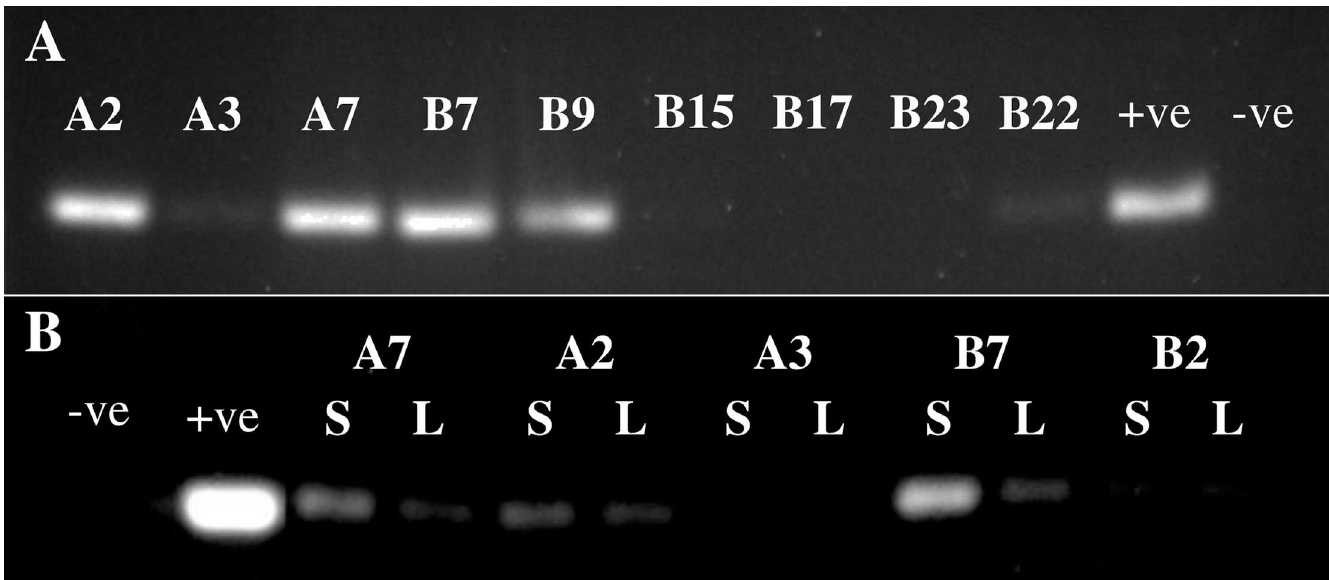
Fig 1. Detection of RLEP sequence by PCR in armadillo tissues. A) Analysis of PCR RLEP product from spleen samples from nine different armadillos. B) Analysis of RLEP from paired samples of liver (L) and spleen (S) from five different armadillos. The signal from positive samples is consistently stronger in the spleen for each individual. The positive control (+ve) reaction included purified M . leprae DNA, 2 ng, while the negative control (-ve) lacked DNA template.